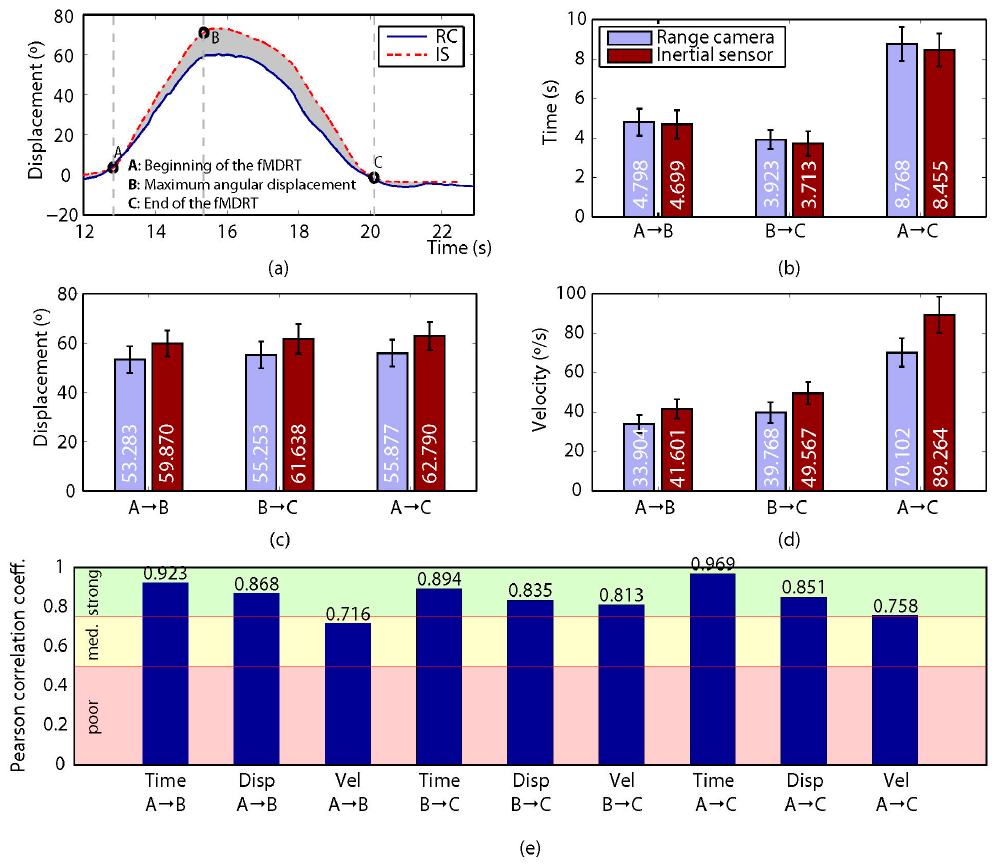
Figure 4. Results for the forward MDRT. ( a ) Comparison of the measured displacement provided by the depth camera (solid blue) and the inertial sensor (dashed red) for a representative participant. The positions of the defined control points are also shown; ( b – d ) mean time (with CI 95%), mean angular displacement (with CI 95%) and mean angular velocity (with CI 95%), respectively, over all the participants for the intervals defined by the control points; ( e ) Pearson Correlation Coefficient (r) (p < 0.005) between the devices for all the measured variables. (Time is expressed in seconds, angular displacement in degrees, and angular velocity in degrees per second).